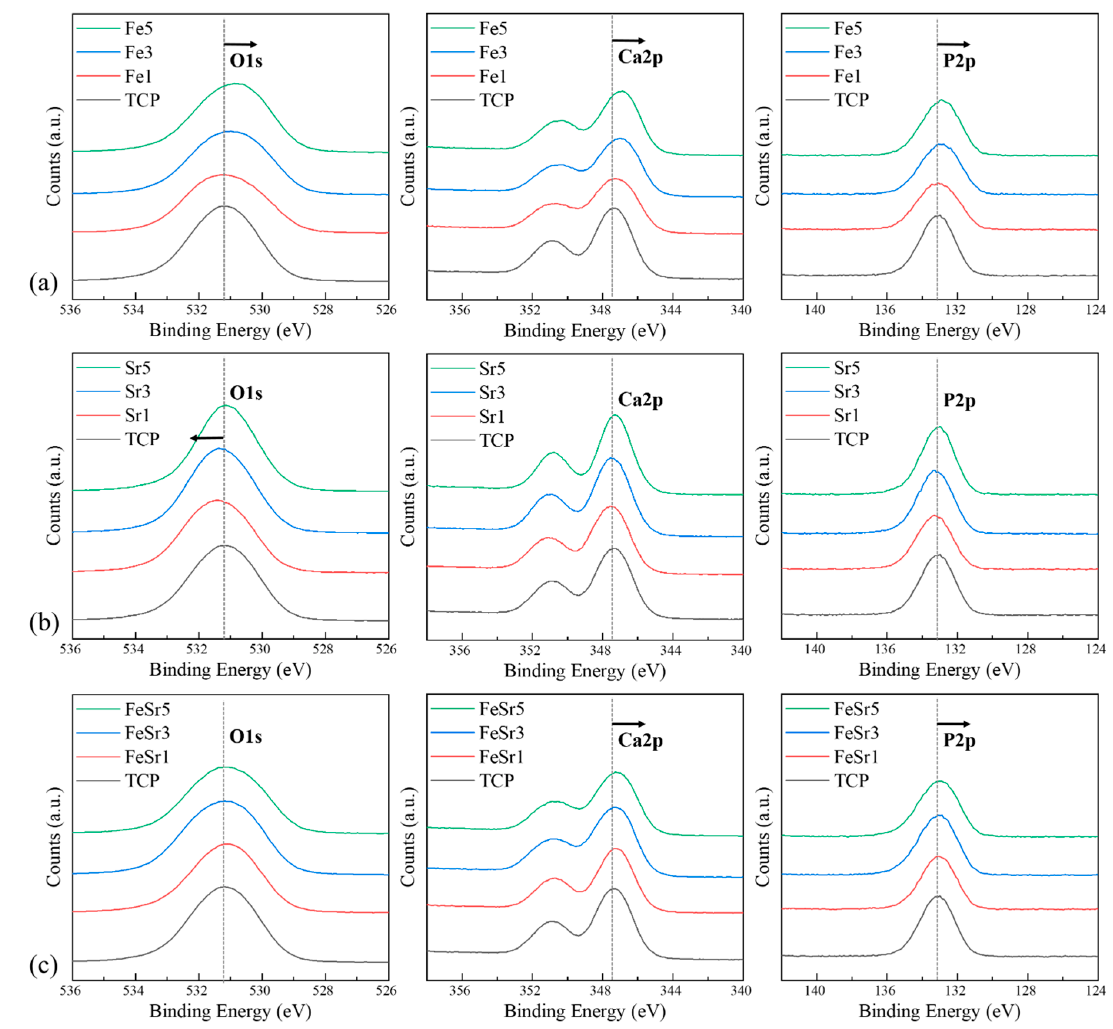
Figure 7. XPS spectra of various β -TCP powders with: ( a ) Fe-substituted samples, ( b ) Sr-substituted samples, ( c ) Fe/Sr co-substituted samples.